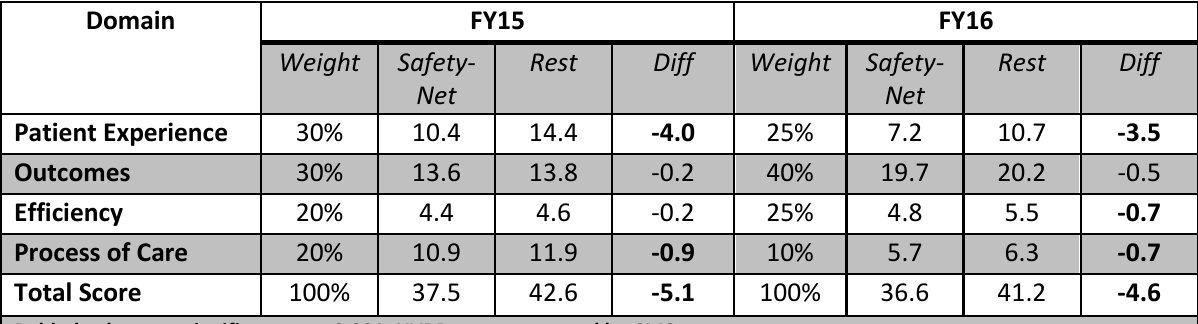
Table 7.9. FY15 and FY16 HVBP Domain and Total Performance Scores, by Hospital Safety-Net Status